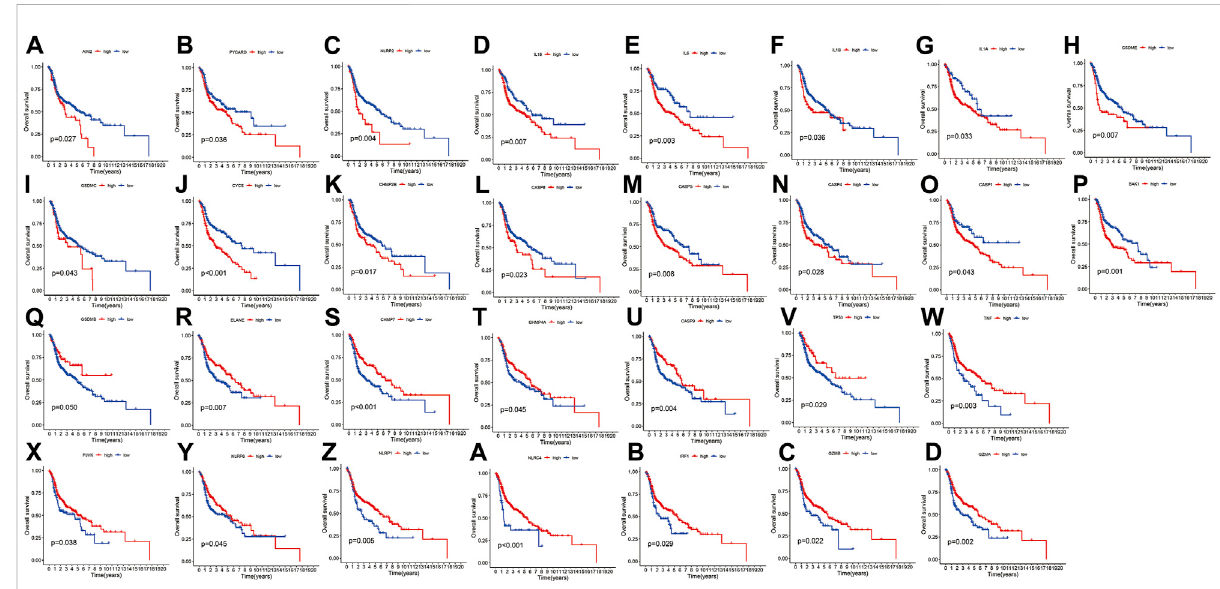
FIGURE 3 Kaplan-Meier curve for OS of 30 pyroptosis regulators. (A – Z, A – D) The association between 16 pyroptosis regulators with positive regulation and 14 with negative regulation and